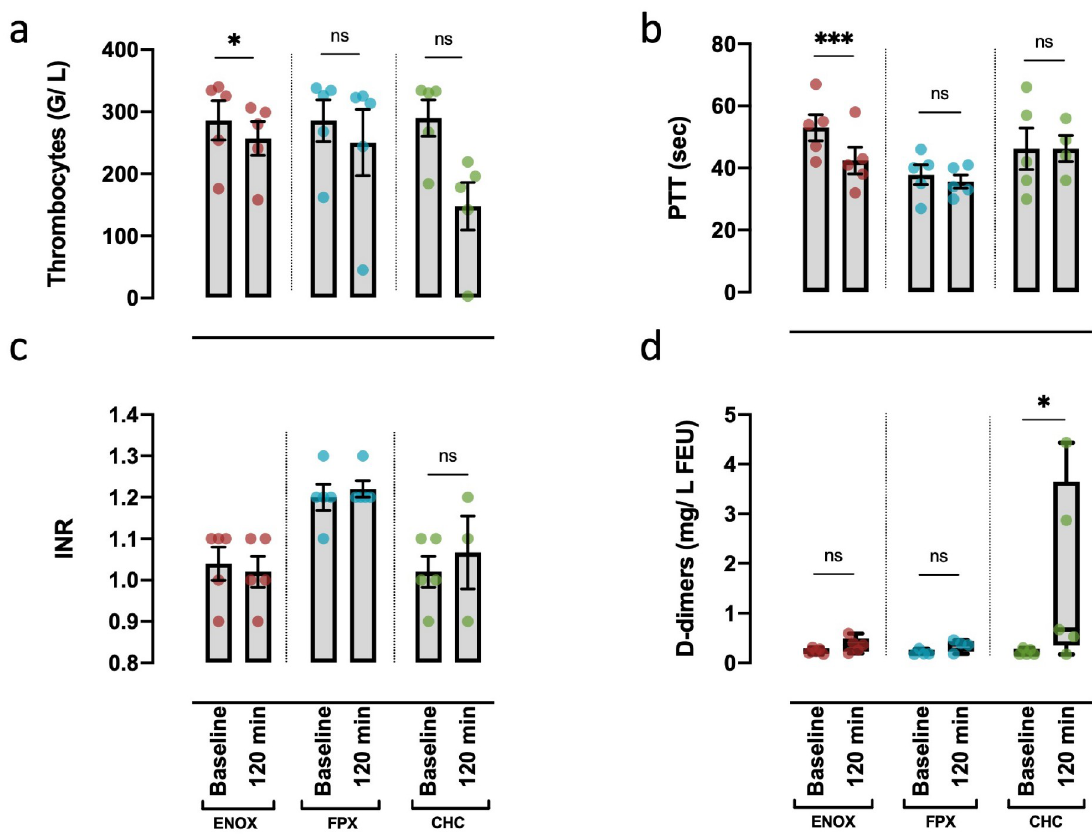
Fig 2. Differential impact of various anticoagulant strategies on coagulation parameters two hours after incubation. Measurement of the global parameters thrombocyte count (a), PTT (b) and INR (c) for cellular and plasmatic coagulation. D-dimers were measured as parameter for fibrinolysis (d). Values were obtained by measuring blood samples both directly after blood drawing (Baseline) and after 120 minutes of incubation. For statistical analysis, RM one-way ANOVA (a, c) and mixed-effect model (b) were performed with Geisser- Greenhouse correction. For each model mean values at baseline and 120 min were compared using Sidaks multiple comparison test. For d-dimers the non-parametrical Kruskal-wallis test (d) was performed, comparing mean values at baseline and 120 min of each model using Dunn’s multiple comparison test. � p < 0.05; ��� p < 0.001; ns: Not significant. Values presented as mean + s.e.m (a, b, c) and median ± range (d). All samples: n = 5, except for CHC 120 min (b, c), FPX baseline, 120 min (d): n = 3–4, due to technical reasons (b, c) and due to exclusion of an outlier (d: 4.43 mg/L